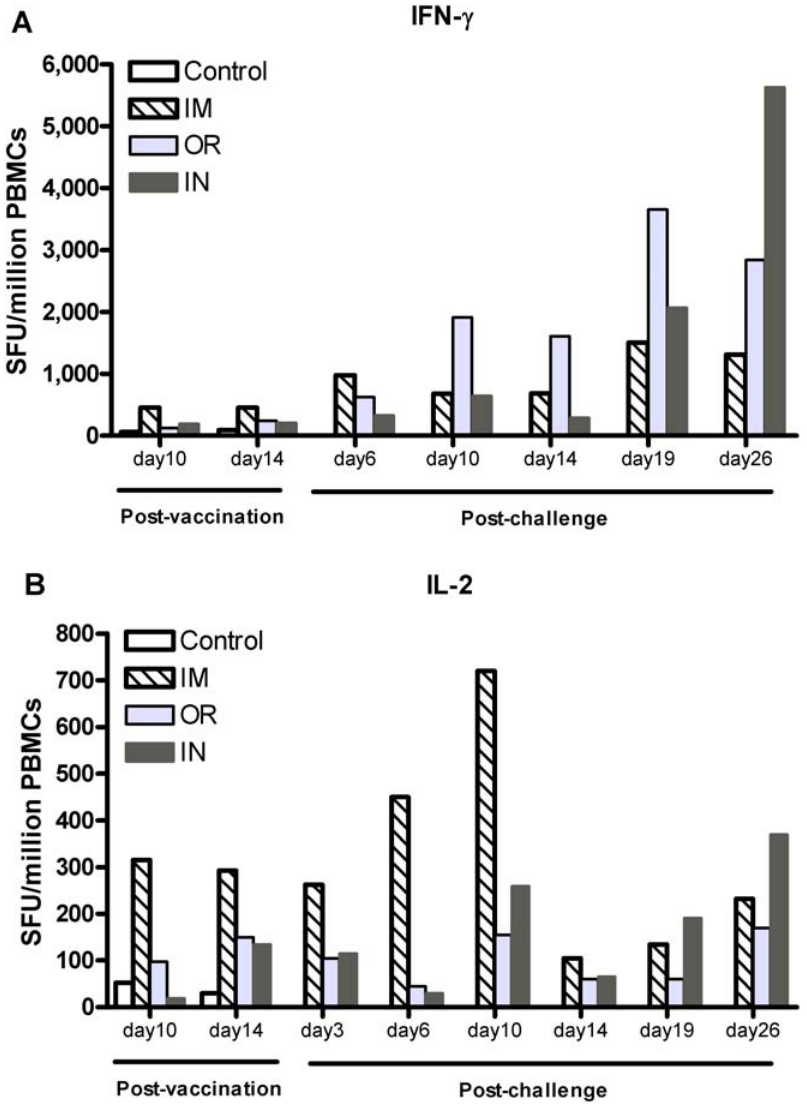
Figure 4. PBMCs from immunized animals produce IFN- c or IL-2 in response to ZEBOVGP peptides. ZEBOVGP-specific IFN- c or IL-2 secreting cells from PBMCs were detected by either an (A) IFN- c or (B) IL-2 ELISPOT assay. PBMCs were obtained from cynomolgus macaques immunized with VSV D G/ZEBOVGP either orally (OR; n=4), intranasally (IN; n=4), or intramuscularly (IM; n=2). The control NHPs (n=2) were immunized IM with the heterologous VSV D G/MARVGP. PBMCs were incubated with 1.5 m g/ml of peptides spanning the entire ZEBOV glycoprotein. Bars represent the average number of ZEBOVGP-specific IFN- c or IL-2 secreting cells detected in each immunized group.